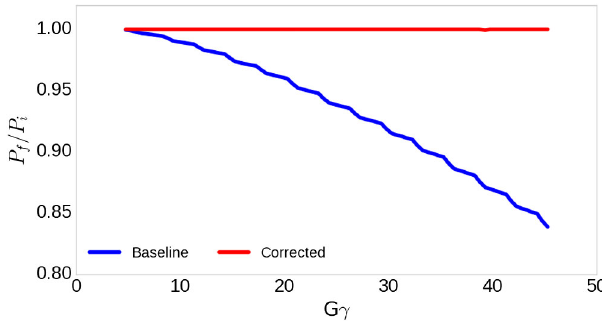
FIG. 4. Cumulative polarization loss due to horizontal intrinsic resonances before and after correction. Estimated using the Froissart-Stora and the calculated resonance